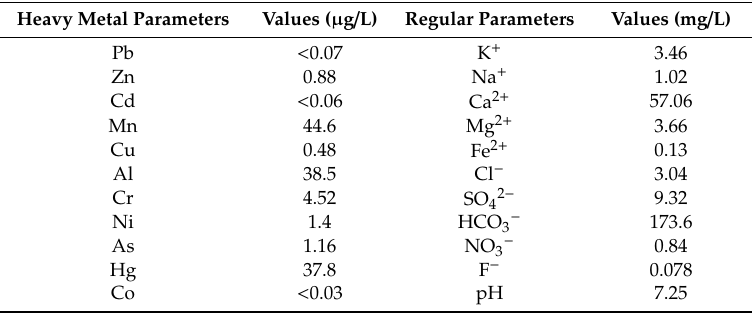
Table 2. Water quality parameters in the experimental karst